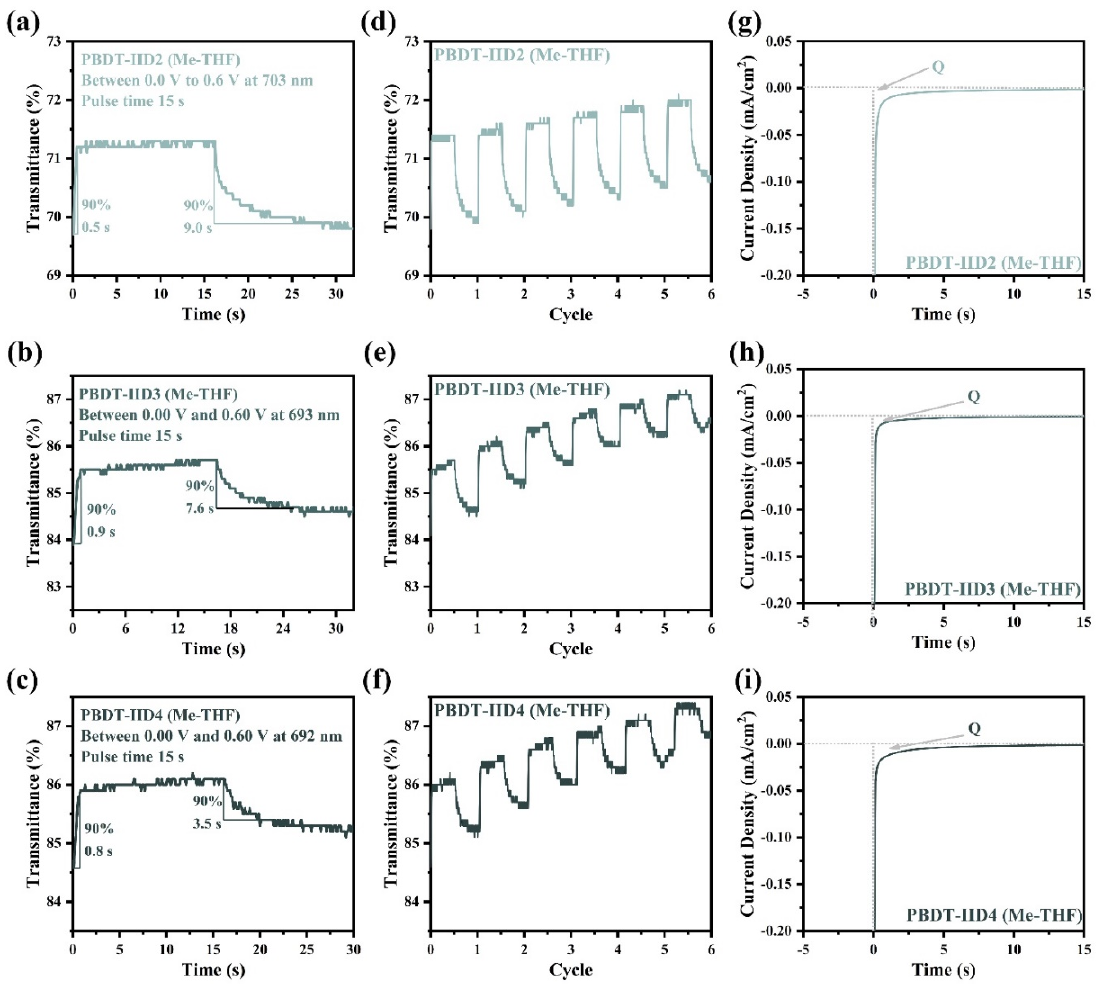
Figure 7. ( a – c ) The coloring/bleaching time and the optical contrast of PBDT-IID2, PBDT-IID3, and PBDT-IID4; ( d – f ) The variation of the optical contrast with the cycle number for PBDT-IID2, PBDT-IID3, and PBDT-IID4; ( g – i ) The current versus time curves of PBDT-IID2, PBDT-IID3, and PBDT-IID4 when coloration occurs. (The processing solvent for polymer films is Me-THF, Q represents the amount of charge injected or extracted per unit area.). Table 4. The electrochromic properties of the PBDT-IIDs.